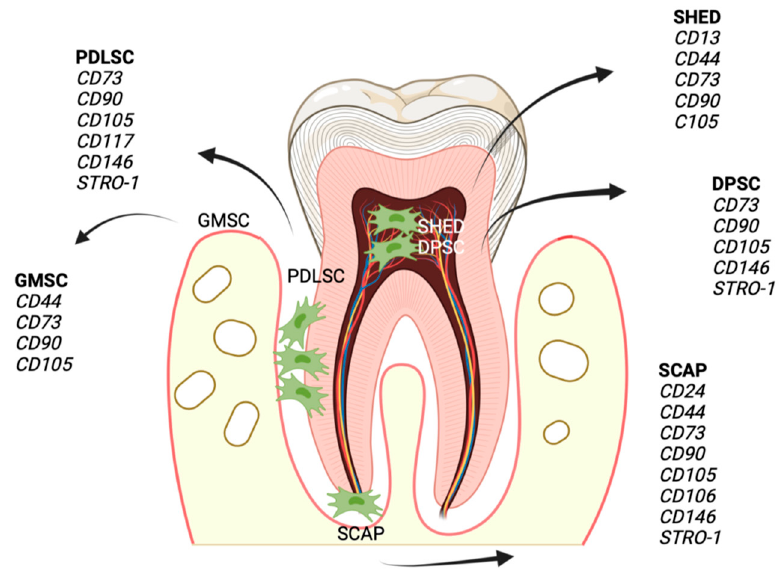
Figure 2. The distribution of DMSCs , their original place and surface markers.